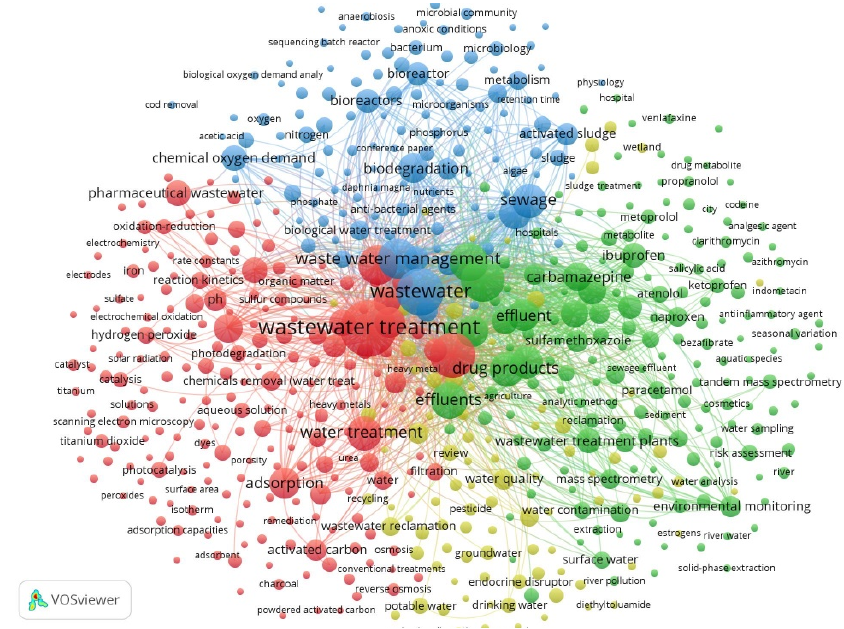
Figure 6. Main keywords network based on co-occurrence.